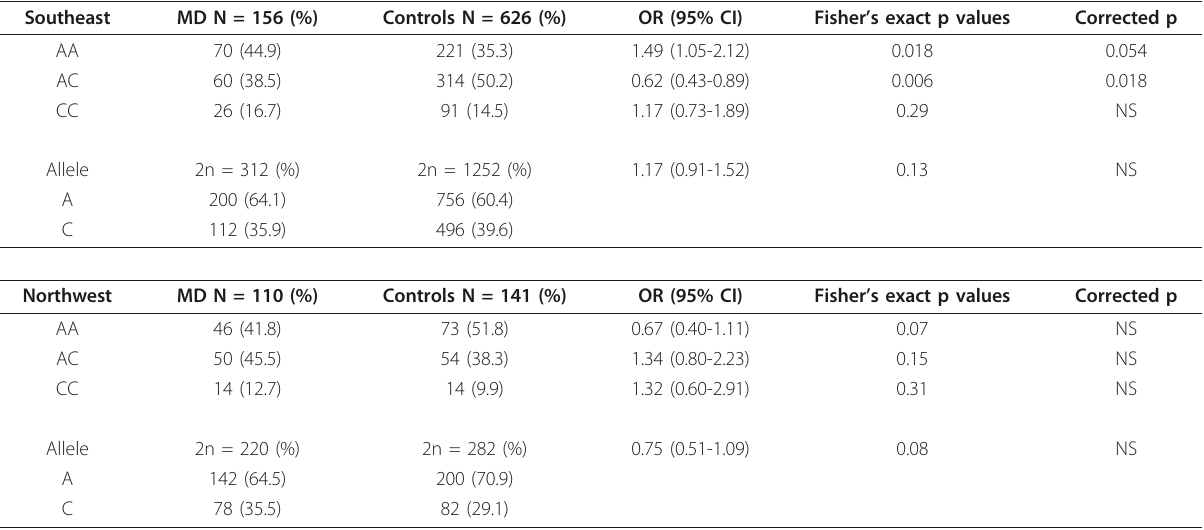
Table 5 Frequency of CD16A alleles and genotypes among MD patients and healthy controls